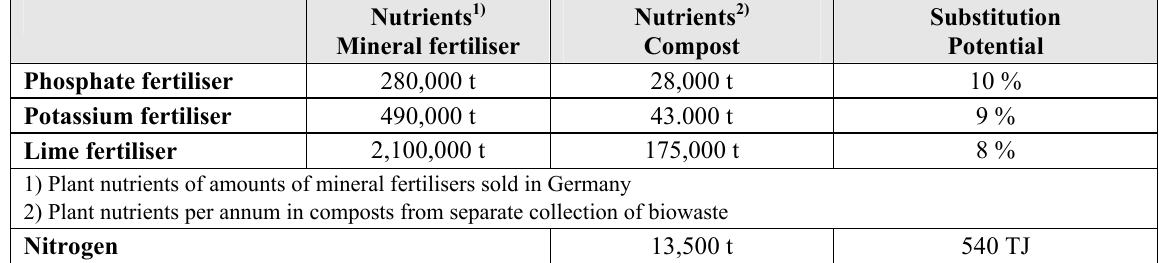
Table 38: Potential of fertiliser substitution of compost in Germany (Kehres 2008) Nutrients